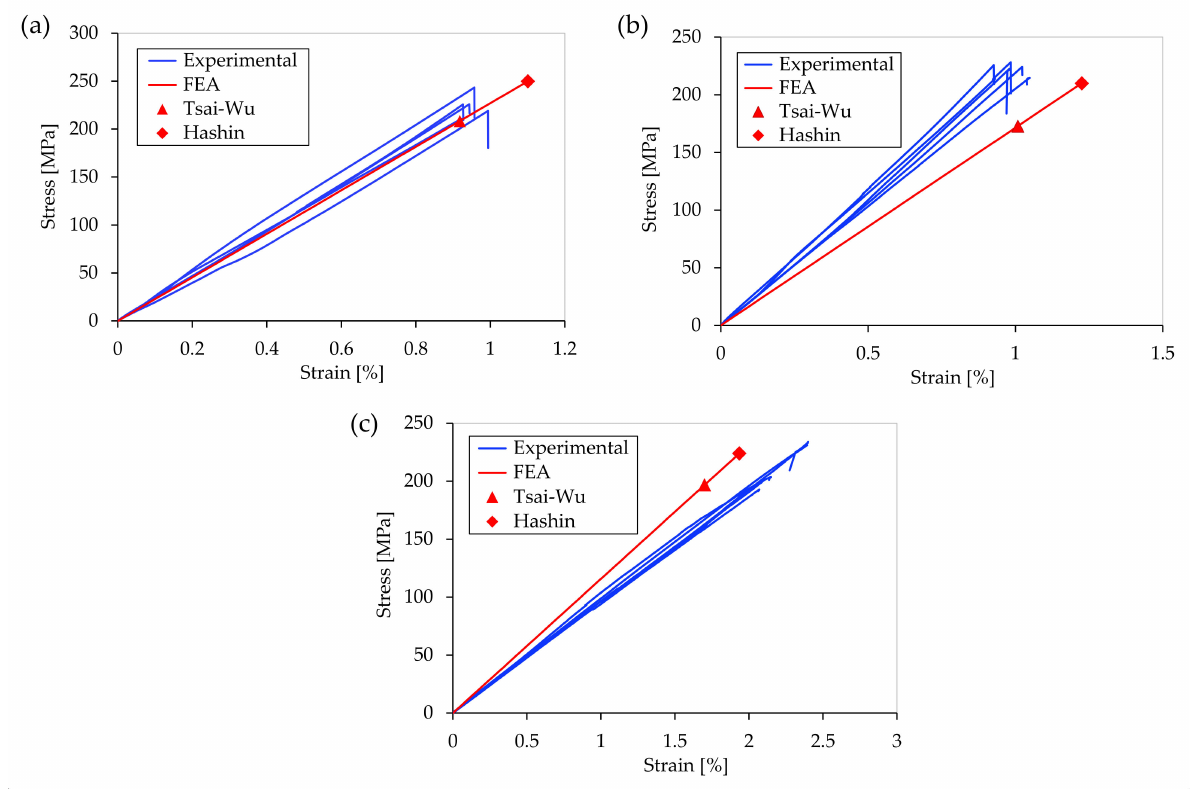
Figure 11. Experimental and numerically calculated stress–strain curves of the tensile tests: ( a ) with carbon fiber reinforcement, ( b ) with hybrid fiber reinforcement, and ( c ) with glass fiber